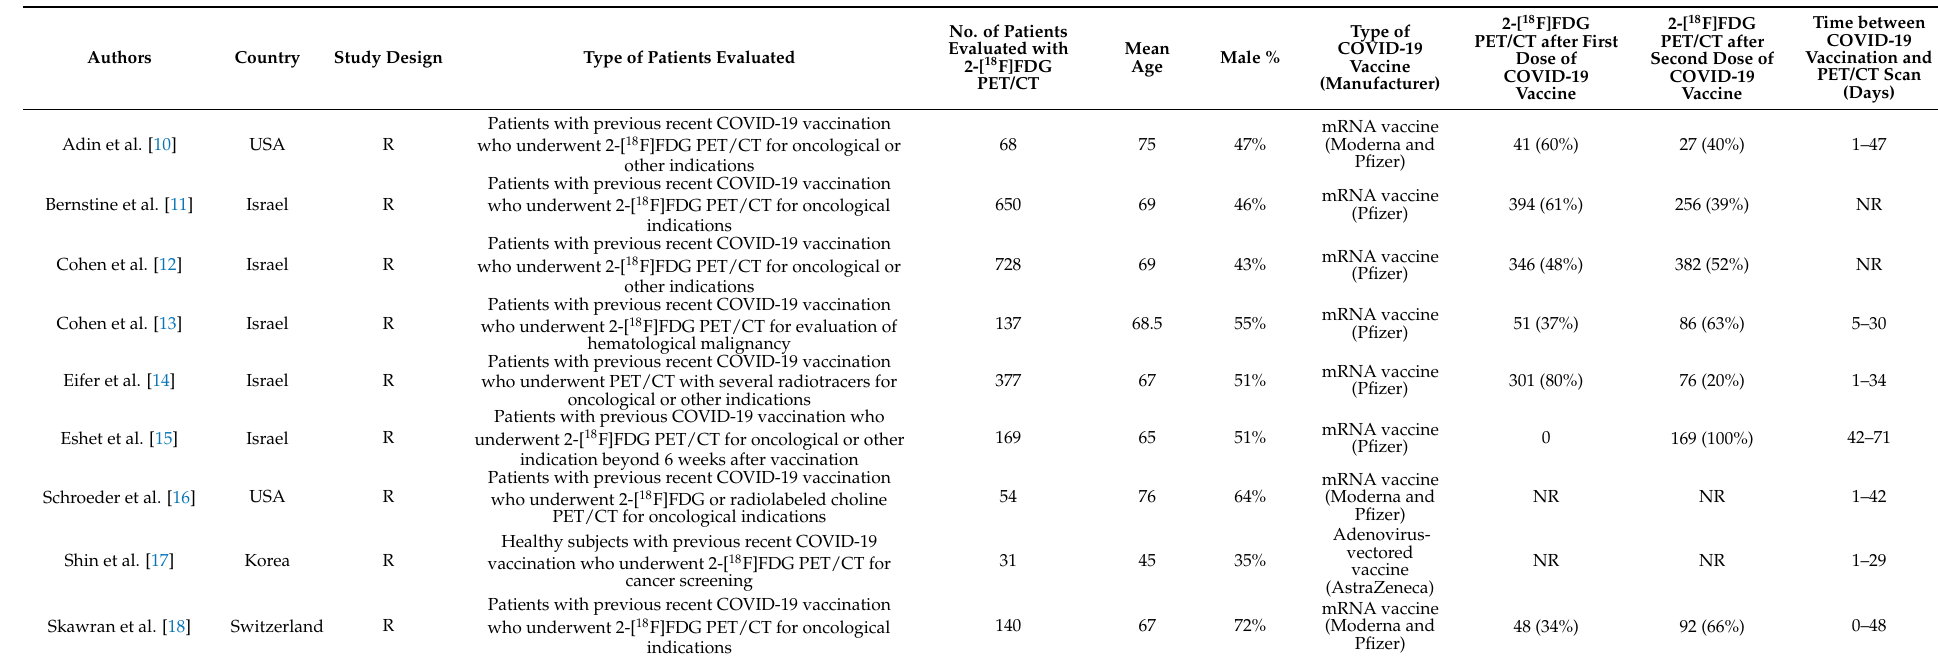
Table 1. Basic study and patient